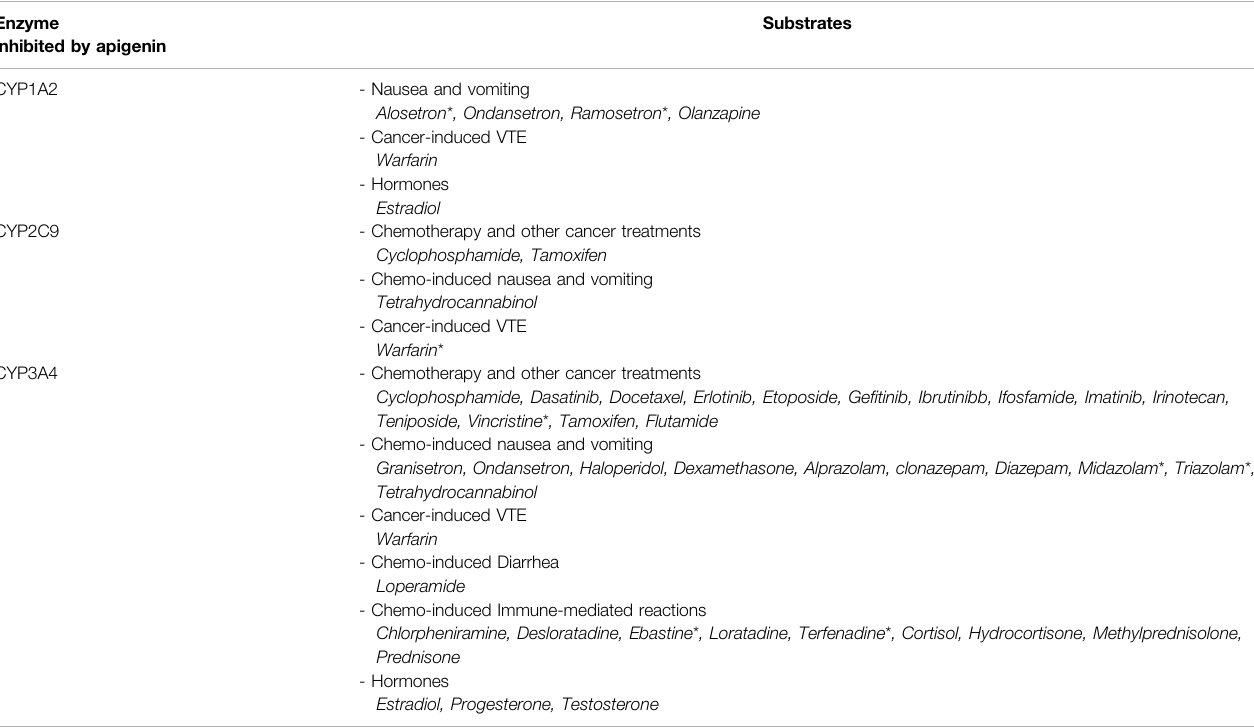
TABLE 3 | CYP enzymes inhibited by apigenin, and their respective substrates of relevance to cancer treatment. Studies have indicated that apigenin is an inhibitor of CYP1A2, CYP2C9, and CYP3A4 (Kleinschmidt and Delaney, 2015). This implicates apigenin in potential drug interactions with a number of chemotherapies and medications used in the supportive care of cancer. If this fl avone were to be taken in conjunction with any one of the interacting substrates, this would lead to decreased metabolism and potentially supratherapeutic or toxic plasma levels. Enzyme inhibited by apigenin